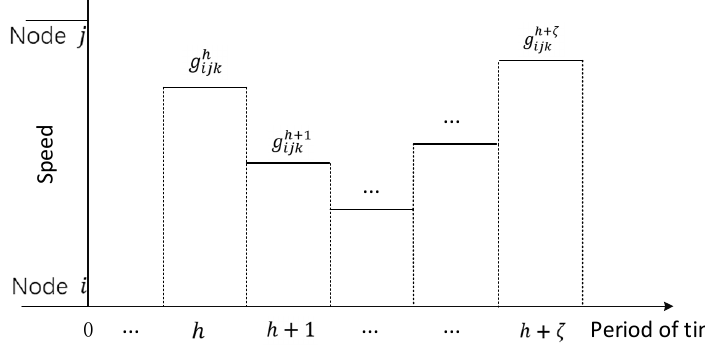
Figure 1. Vehicle speed in different time